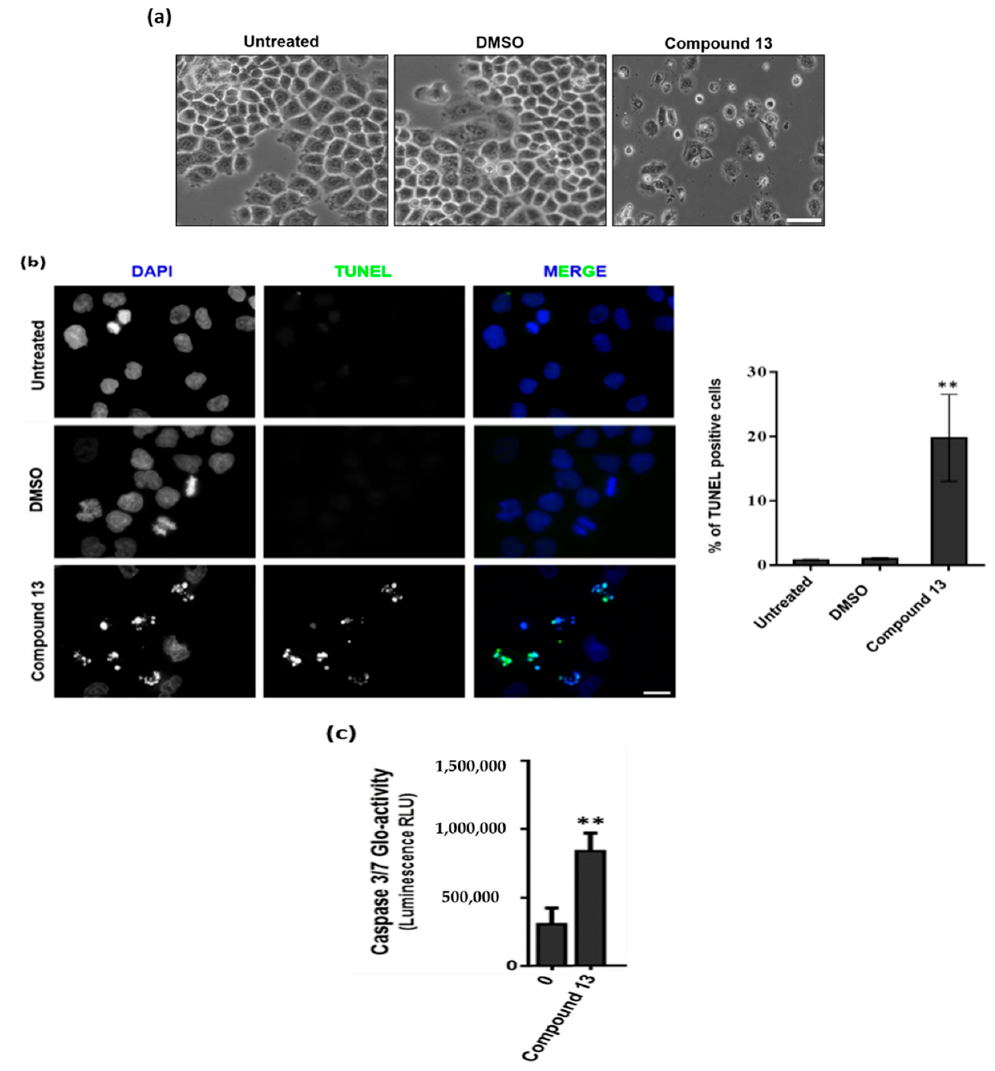
Figure 2. Compound 13 induces apoptotic cell death through caspase 7 activation in MCF-7 cells. ( a ) Representative phase contrast microscopy fields of untreated, 0.04% DMSO- and 4 × GI 50 compound 13 -treated cells for 30 h. Scale bar = 20 µ m. ( b ) ( Left ) Cells treated with compound 13 for 30 h and stained with TUNEL to detect apoptotic cells (green). DNA (blue) was stained with DAPI. Untreated- and 0.04% DMSO-treated cells were used as control. Scale bar = 5 μ m. ( Right ) Quantification of data shown in left panel. ** p = 0.0082 (Unpaired T-test). ( c ) Caspase 3/7 Glo-activity of cells treated with 23.46 µ M of compound 13 for 24 h. DMSO-treated cells (0) were used as control. ** p = 0.0051 (Unpaired